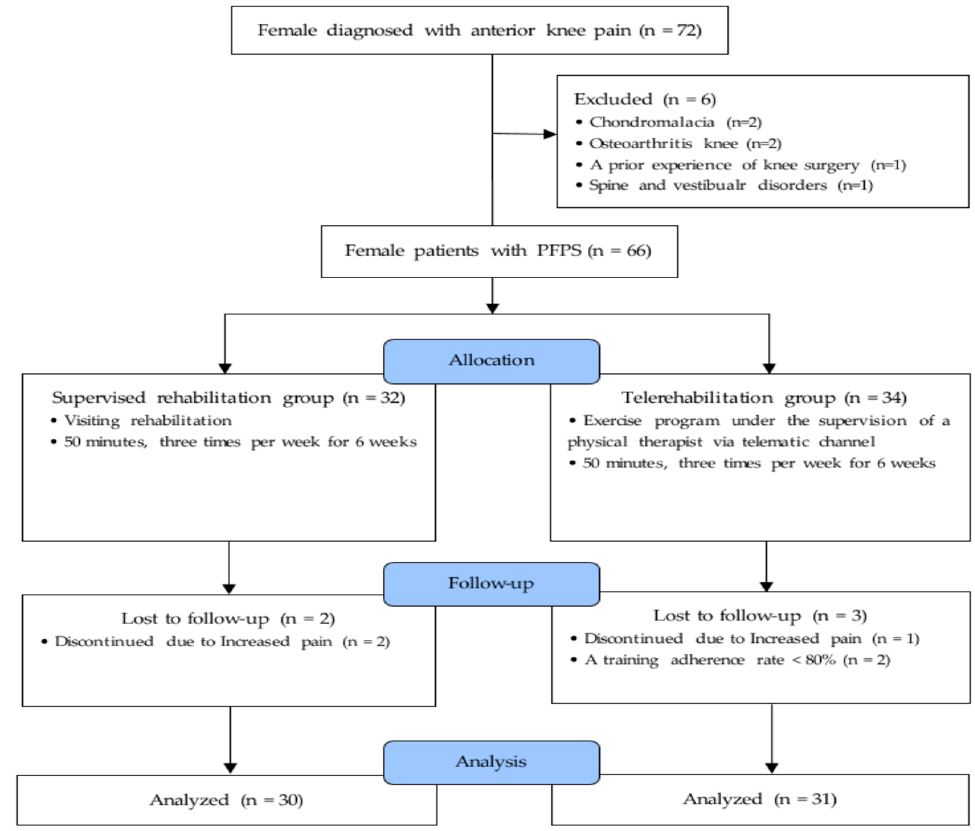
Figure 1. Study flow diagram.